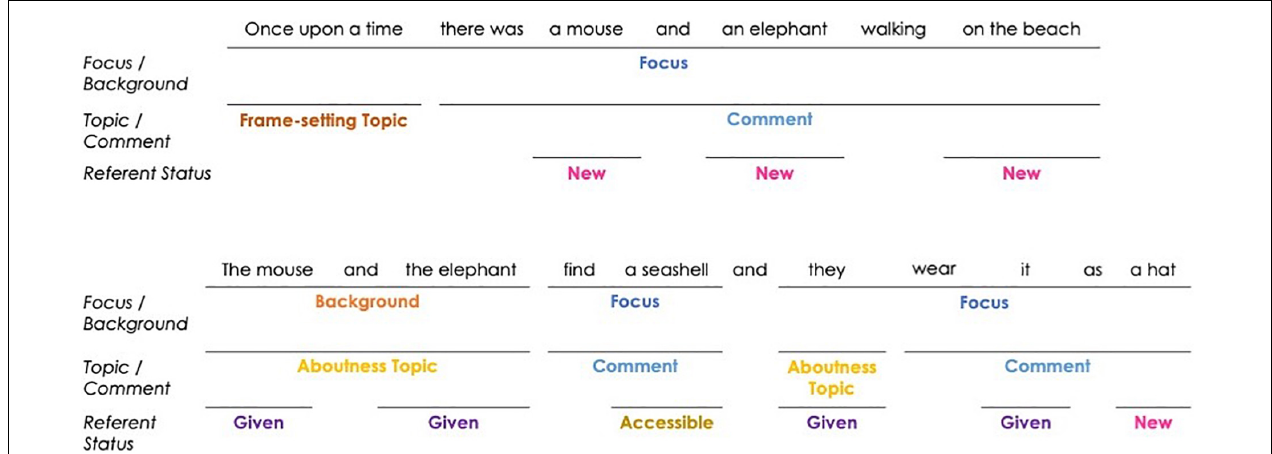
FIGURE 4 | The information structure (IS) of a child’s narrative. Please see the Supplementary Appendix to see a complete example of the Gesture/IS coding and for more examples of each